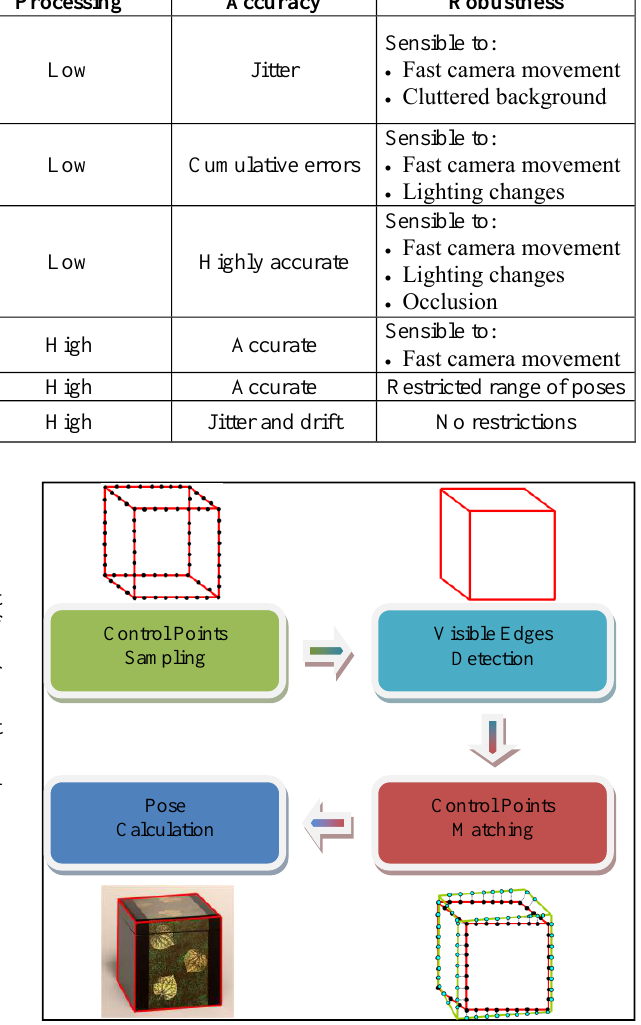
Figure 5. PS technique workflow